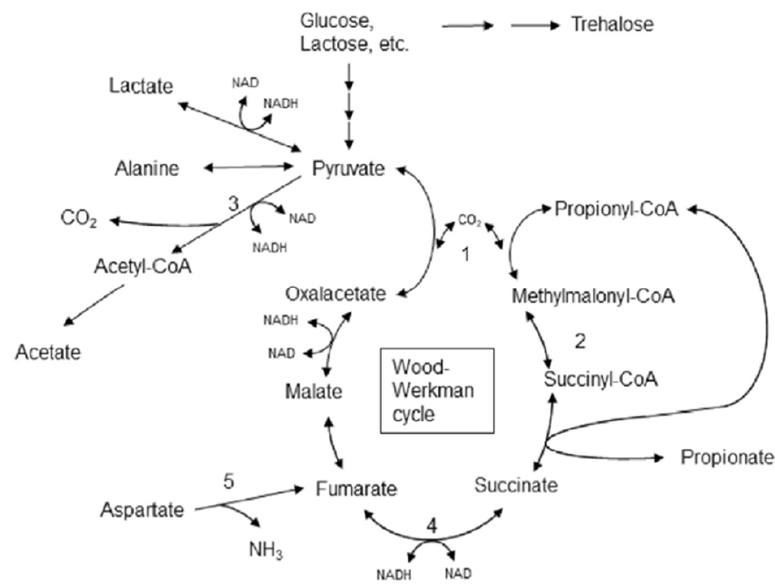
Figure 4. Lactose and lactate fermentation by propionic acid bacteria [26, distributed under a Crea ‐ tive Commons Attribution] (1—Methylmalonyl ‐ CoA carboxytransferase, 2—Methylmalonyl ‐ CoA mutase, 3—Pyruvate dehydrogenase, 4—Fumarate reductase, 5—Aspartate ammonia ‐ lyase).